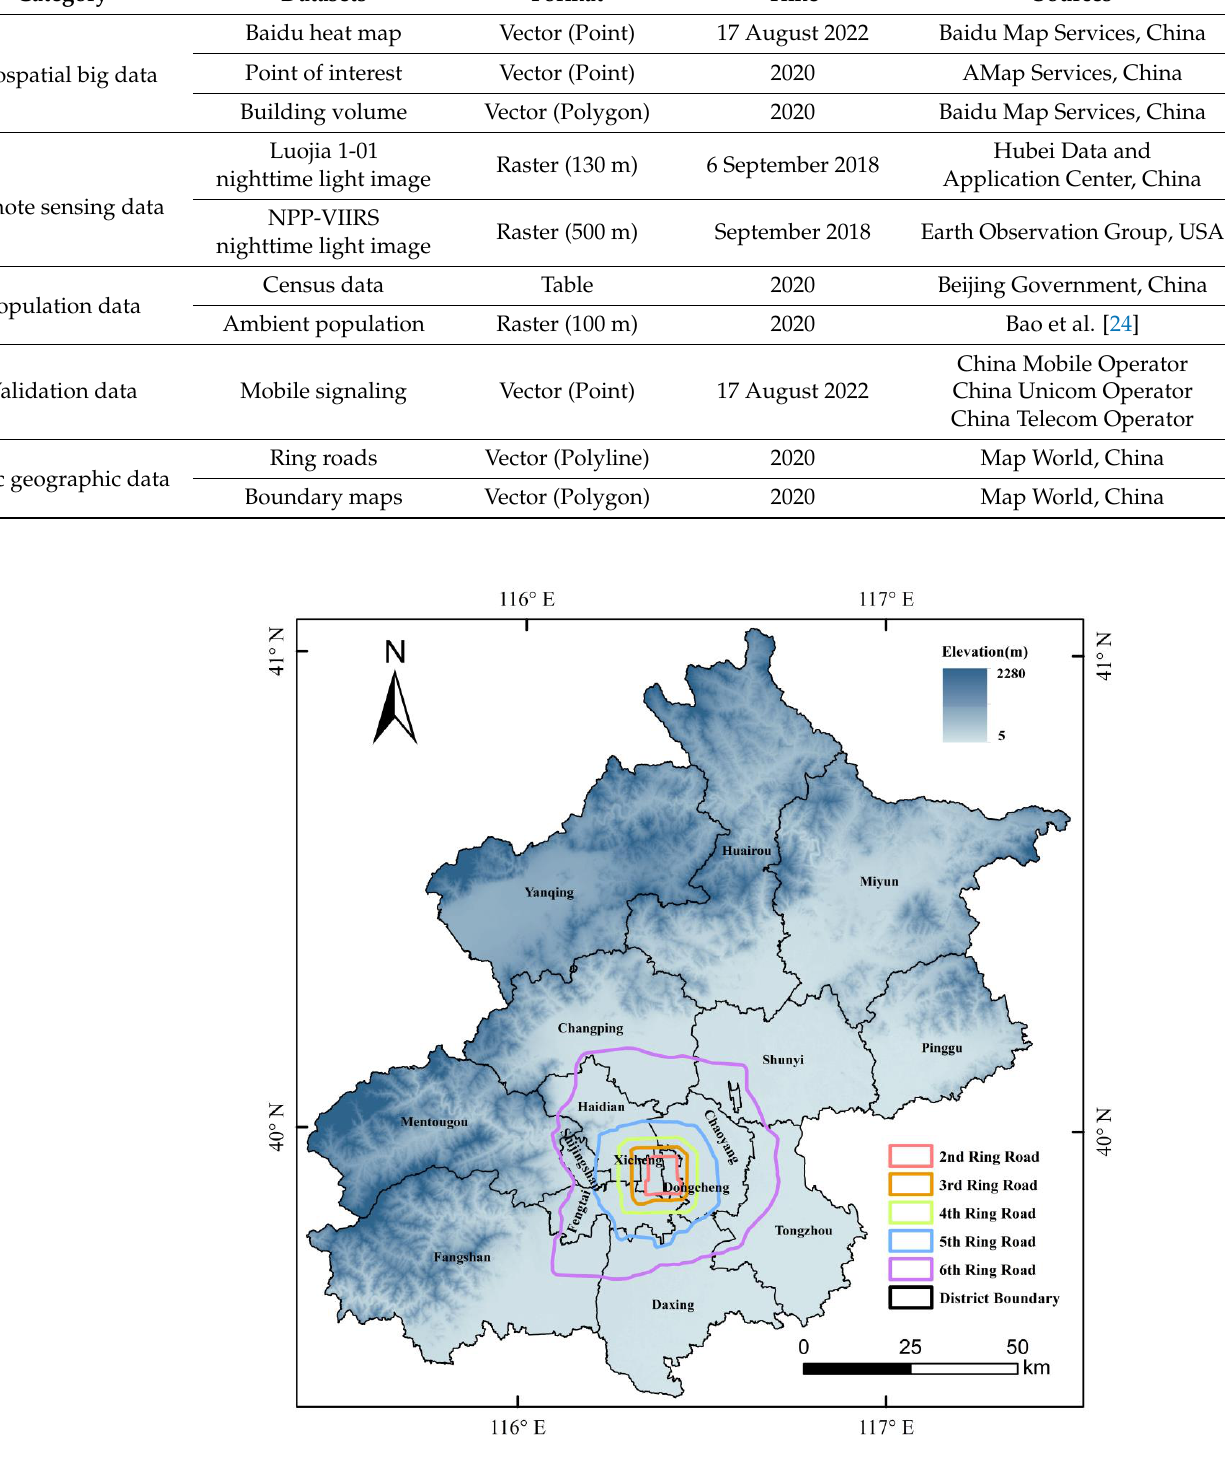
Figure 1. Geographical location and overall situation of